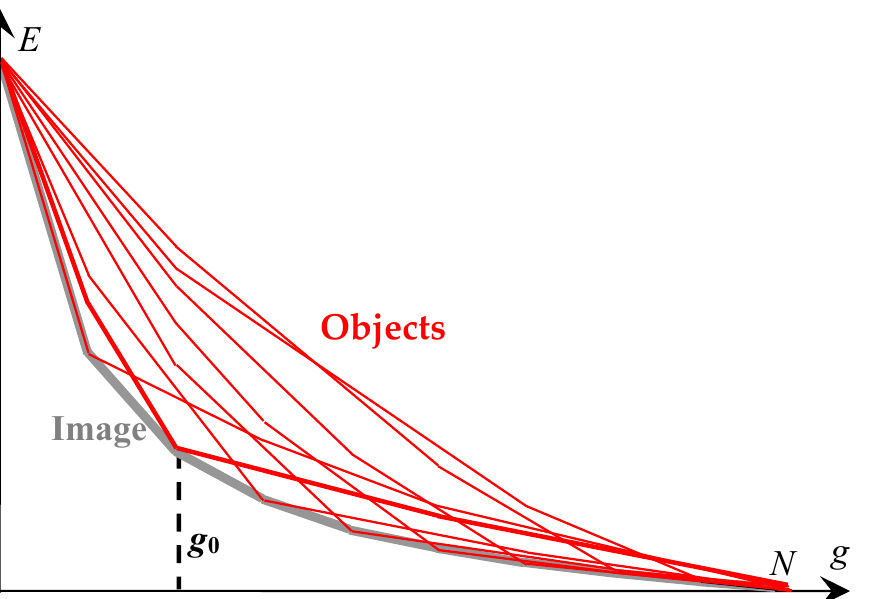
Figure 11. Parameterized approaching of an image by a hierarchical sequence of approximations in g 0 = 1, 2,..., N colors. The lower gray convex curve describes E g sequence of optimal image ap- proximations. The remaining red convex curves describe the hierarchies E g sequences of image approximations each containing at least one optimal approximation, in g 0 = 1, 2, ..., N colors.